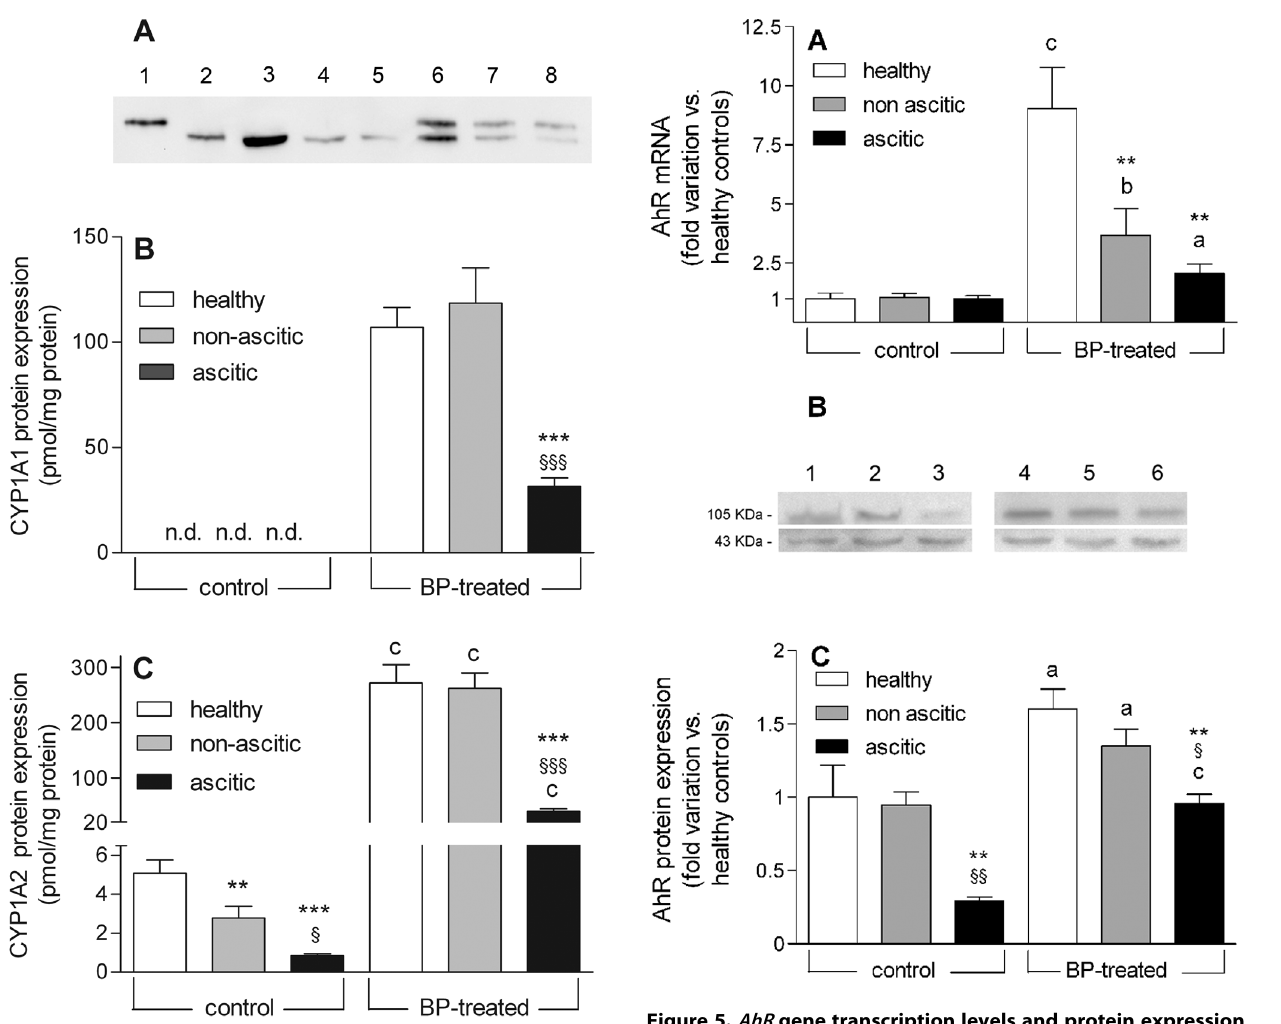
Figure 4. Western blot analysis of CYP1A1 and CYP1A2 proteins. (A) Representative blot showing the separation of micro- somal proteins obtained from control and BP-treated rats. The amounts of microsomal proteins loaded per lane were 10 and 0.5 m g for control and BP-treated rats, respectively. As reference standards, 0.1 pmol of rat recombinant CYP1A1 protein and 0.25 pmol of rat recombinant CYP1A2 protein were loaded in lanes 1 and 2, respectively. Lanes 3 to 5: healthy, non-ascitic and ascitic control rats; lanes 6 to 8: healthy, non- ascitic and ascitic BP-treated rats. Lower Panels : Levels of CYP1A1 (B) and CYP1A2 (C) proteins present in liver microsomal preparations obtained from control and BP-treated rats. The results are shown as means 6 S.E. of data obtained from 8 rats per group. **P , 0.01, ***P , 0.001 vs. healthy rats. 1 P , 0.05, 111 P , 0.001 vs. non-ascitic cirrhotic rats. c P , 0.001 vs. control rats of the same group.